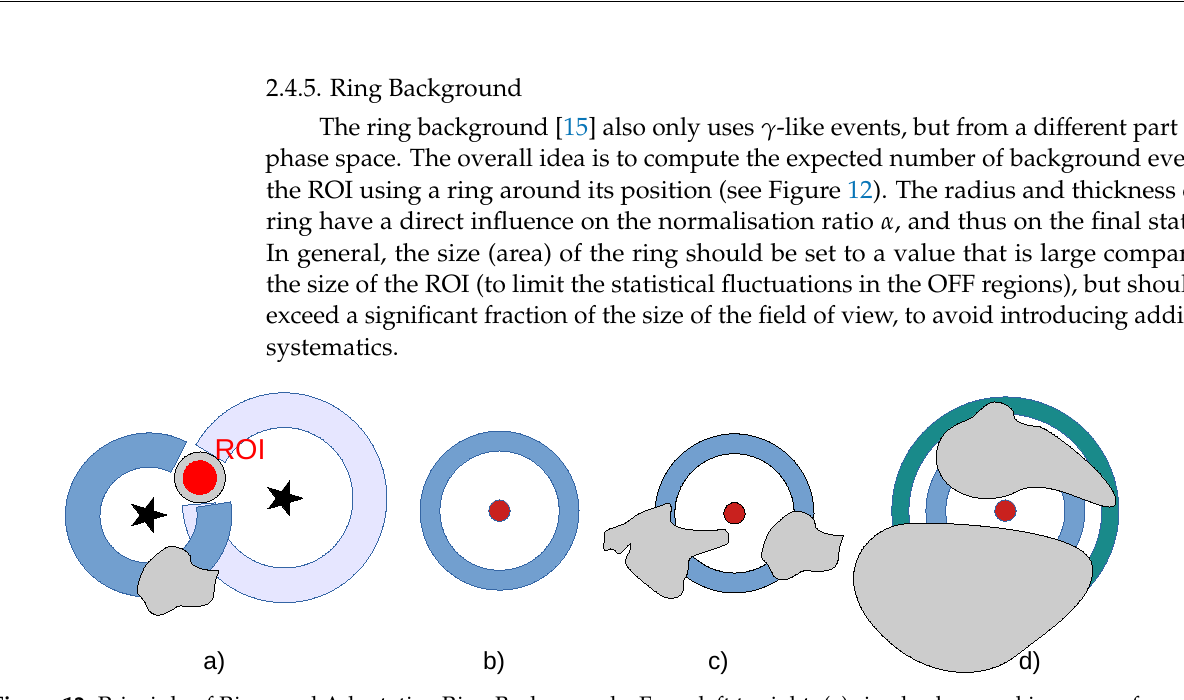
Figure 12. Principle of Ring- and Adaptative Ring Backgrounds. From left to right: ( a ) ring background in camera frame, ( b ) ring background in astronomical frame, ( c ) ring background in astronomical frame with excluded regions ( d ) adaptative ring